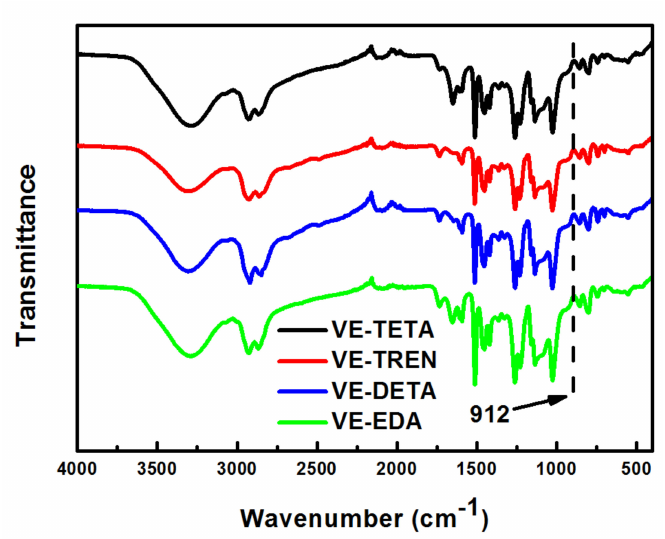
Figure 4. ATR–FTIR analysis of vanillyl alcohol–based bioepoxy resin cured by various curing